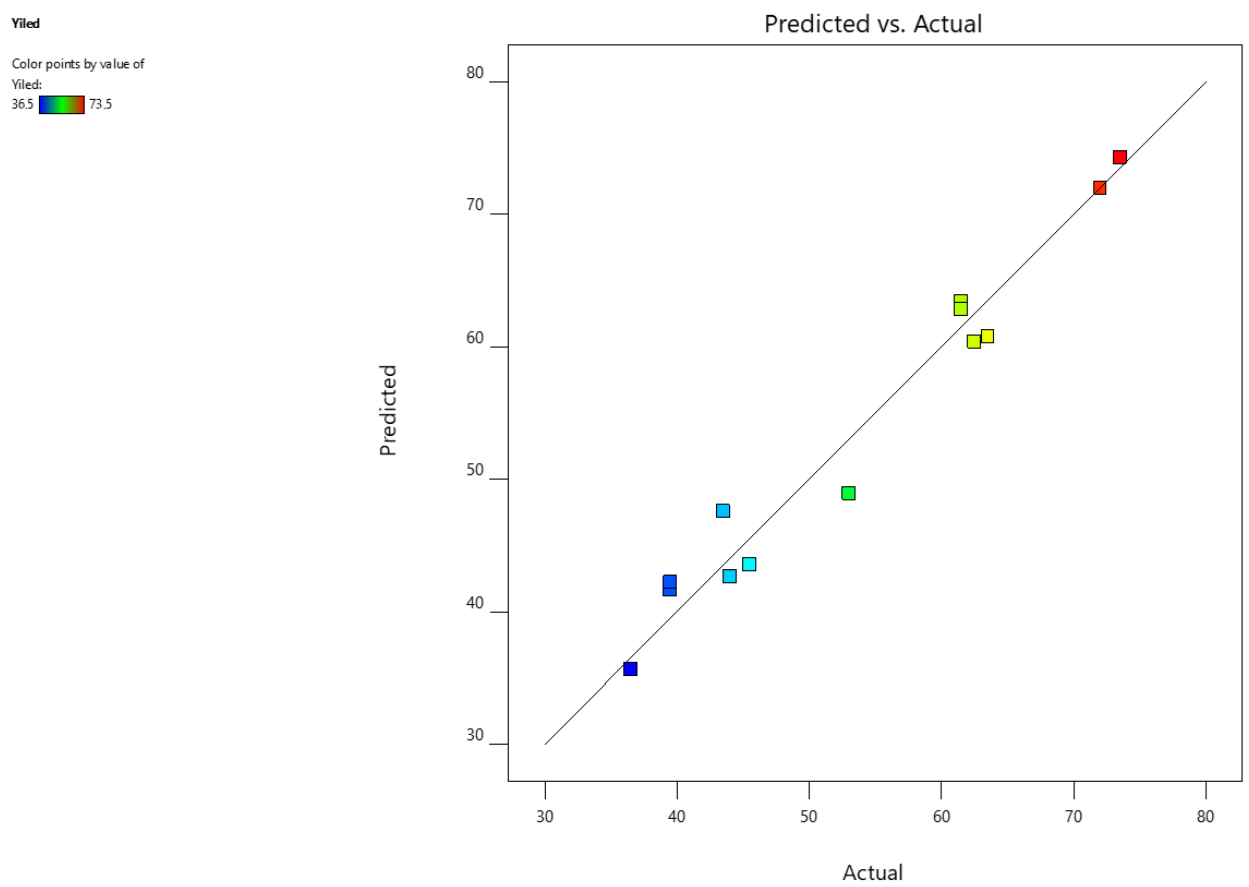
Figure 2. Experimental vs. predicted values for phenolic compound extraction. Y predicted: p < 0.00471; R 2 adjusted = 0.96; R 2 predicted = 0.92.